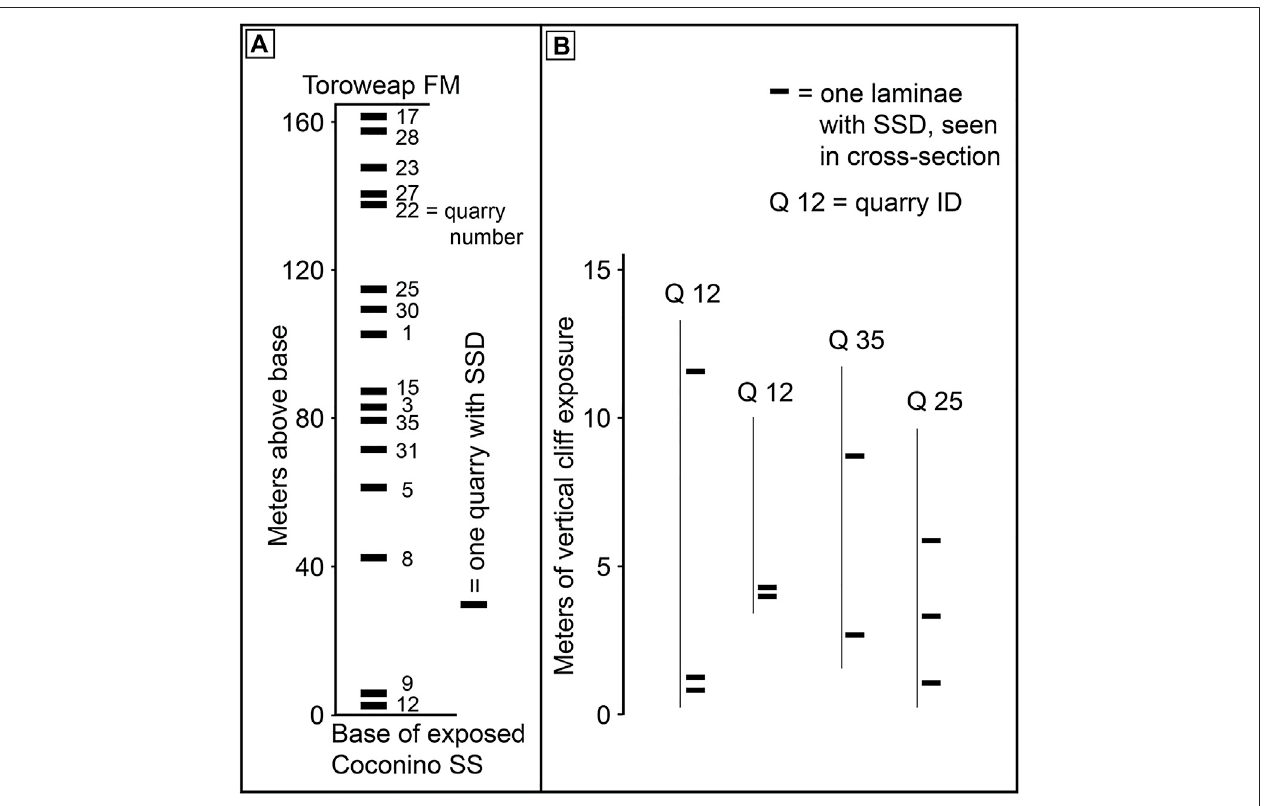
FIGURE 14 | (A) Stratigraphic distribution of quarries near Ash Fork containing ridges, folds, and/or rotated blocks, based on elevation. (B) Vertical distribution of SSD zones as seen in three quarries.